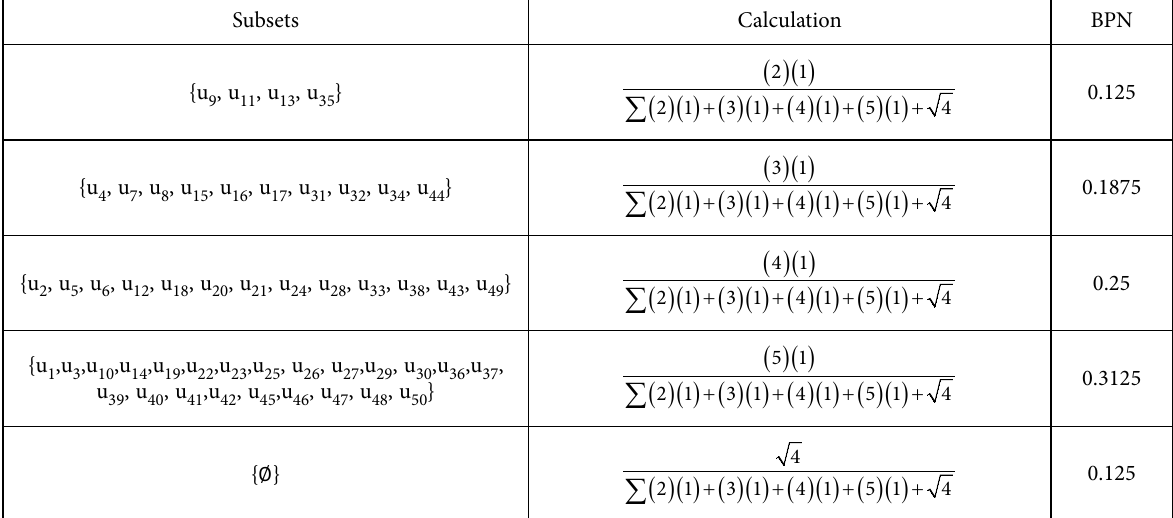
2. Expert’s 1 point of